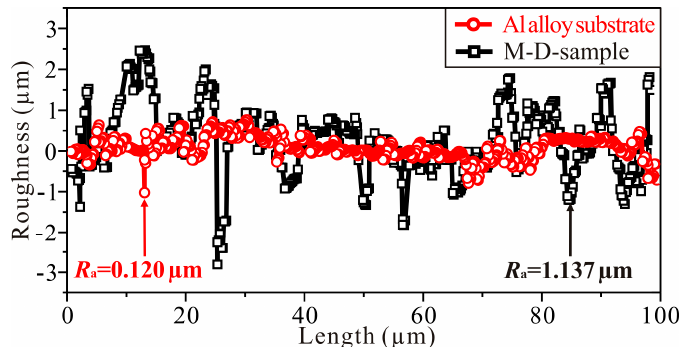
Figure 3. Roughnesses of Al alloy substrate and modified deposited sample (M-D-sample).